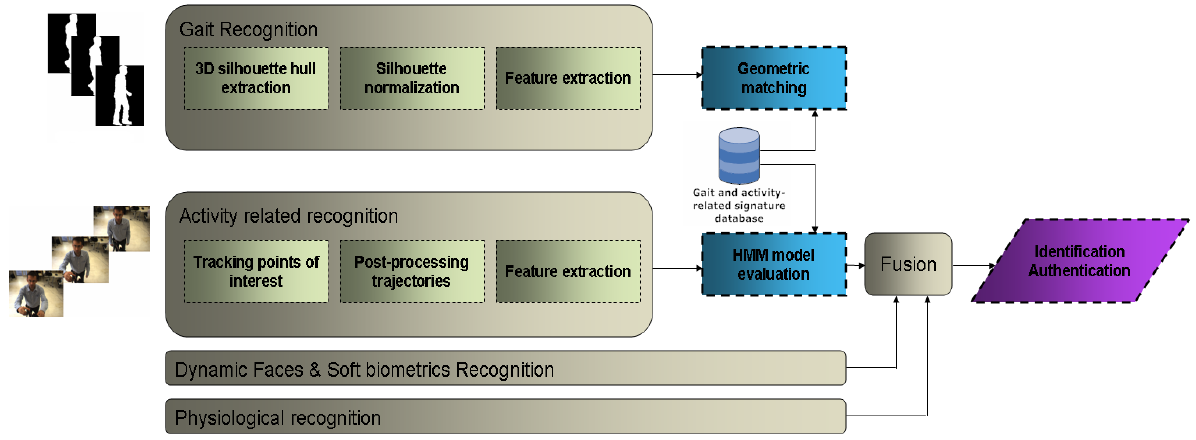
FIGURE 3. The full workplace scenario – system